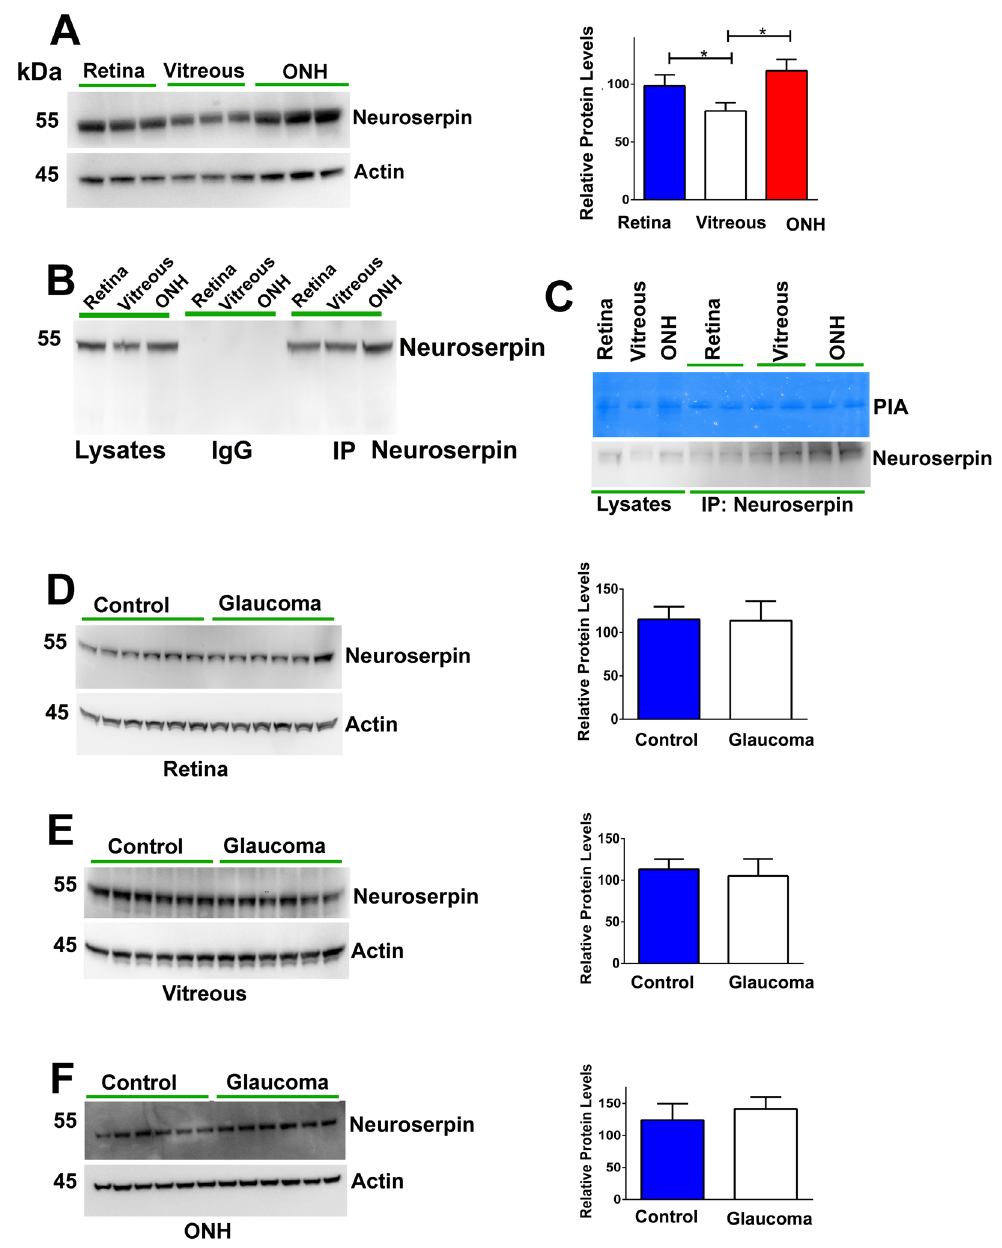
Figure 1. ( A ) Western blot showing neuroserpin expression in the human retina, vitreous and ONH and densitometric quantification of the neuroserpin band intensity (n = 6; * p < 0.05). ( B ) Neuroserpin was immunoprecipitated from human retina, vitreous and ONH samples using anti-neuroserpin antibody (SC32947) and blots probed for neuroserpin immunoreactivity using another neuroserpin antibody (SC48360). Non-reactive IgG was used as control in each case along with corresponding tissue lysates. ( C ) Plasmin inhibitory activity of neuroserpin immunoprecipitated from human retina, vitreous and ONH was assessed using gelatin gel zymography. ( D–F ) Human retina, vitreous and ONH tissue lysates were immunoblotted and probed with anti-neuroserpin antibody using samples obtained from both control and glaucoma subjects (n = 12). Blots were cropped to show the relevant band. The relative intensities of bands in WB were quantified and plotted. Actin was used as internal loading control in each